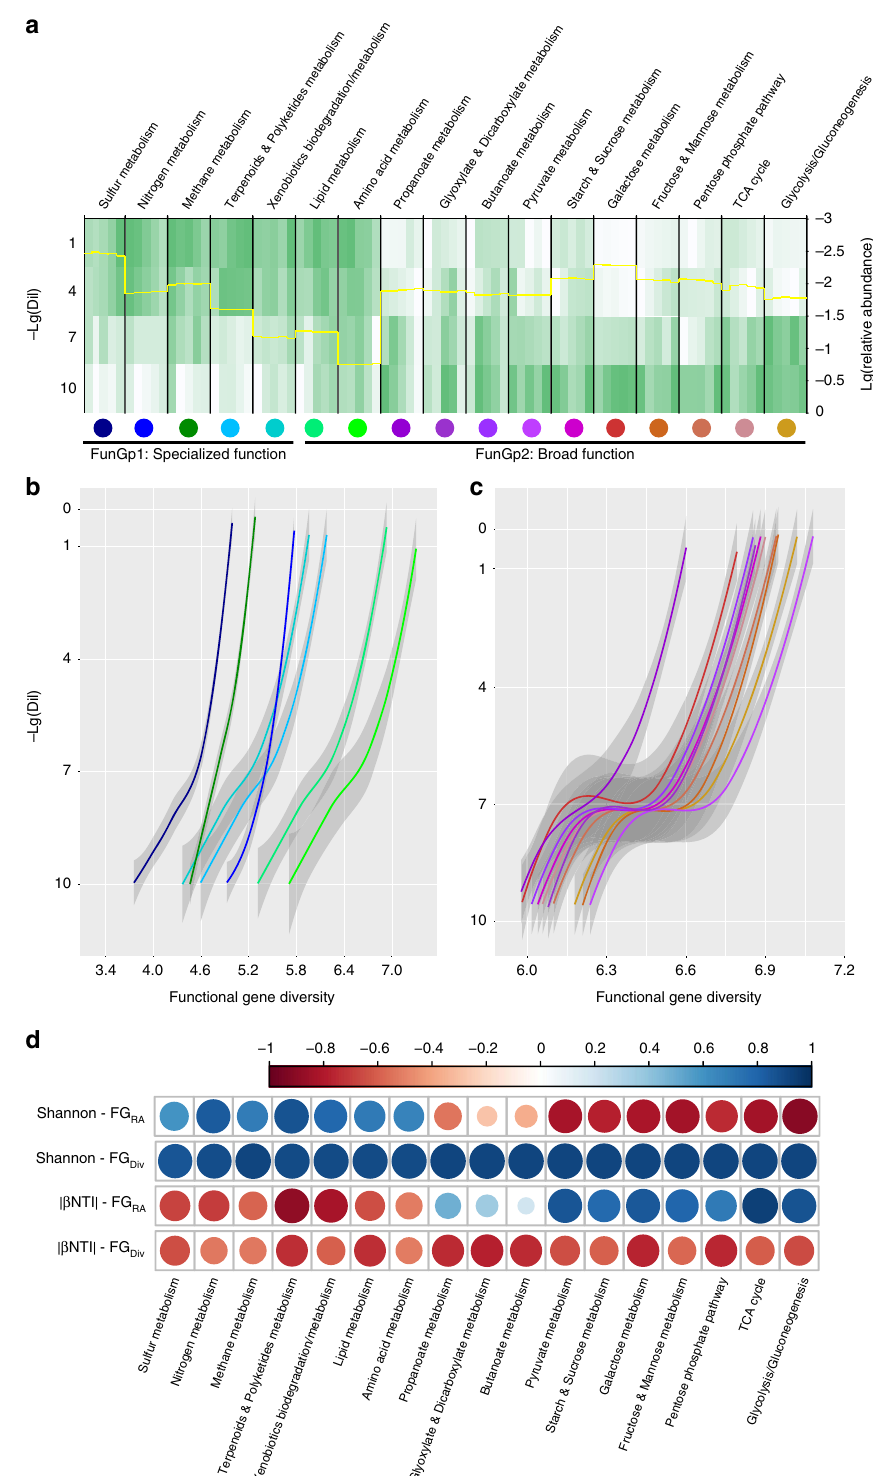
Fig. 4 Functional genes differ in abundance and diversity among treatments. a Heatmap of the relative abundances of different functional categories based on the normalized metagenomic data in 10 − 1 , 10 − 4 , 10 − 7 , and 10 − 10 diluted samples. Color scaled from highest (green) to lowest (white) relative abundances within functional categories. Five columns of each functional category in heatmap indicate the soil pH range from 8.5 (left) to 4.5 (right). Yellow solid line indicates the Lg-transformed relative abundances of various functional categories. b The effect of dilution on specialized functional gene diversity. c The effect of dilution on broad functional gene diversity. The color lines in b and c represent different functional categories indicated by the color points in a . Lg(Dil) indicates the Lg-transformed dilution level. Lg(Dil) = 0 represents the untreated soil. d Correlations between Shannon and FG RA , Shannon and FG Div , | β NTI| and FG RA , and | β NTI| and FG Div . Shannon: bacterial Shannon diversity. FG RA : the relative abundance of a detected functional category. FG Div : the diversity of a detected functional category. The color points in d indicate the correlation coef fi cient (bluer indicates stronger positive correlation and redder indicates stronger negative correlation) and signi fi cance (larger size indicates lower P -value) NATURE COMMUNICATIONS| (2019) 10:3833